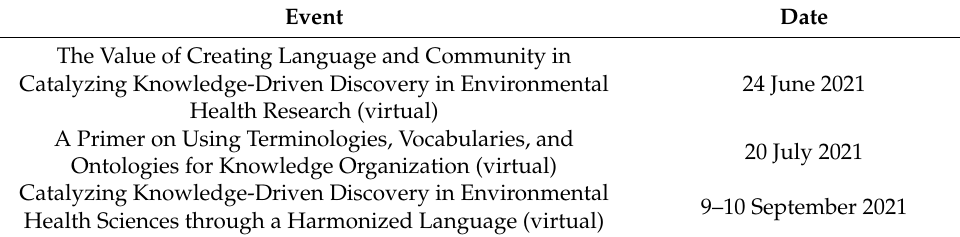
Table 1. Events for the Environmental Health Language Collaborative. Event The Value of Creating Language and Community in Catalyzing Knowledge-Driven Discovery in Environmental Health Research (virtual) A Primer on Using Terminologies, Vocabularies, and Ontologies for Knowledge Organization (virtual) Catalyzing Knowledge-Driven Discovery in Environmental Health Sciences through a Harmonized Language